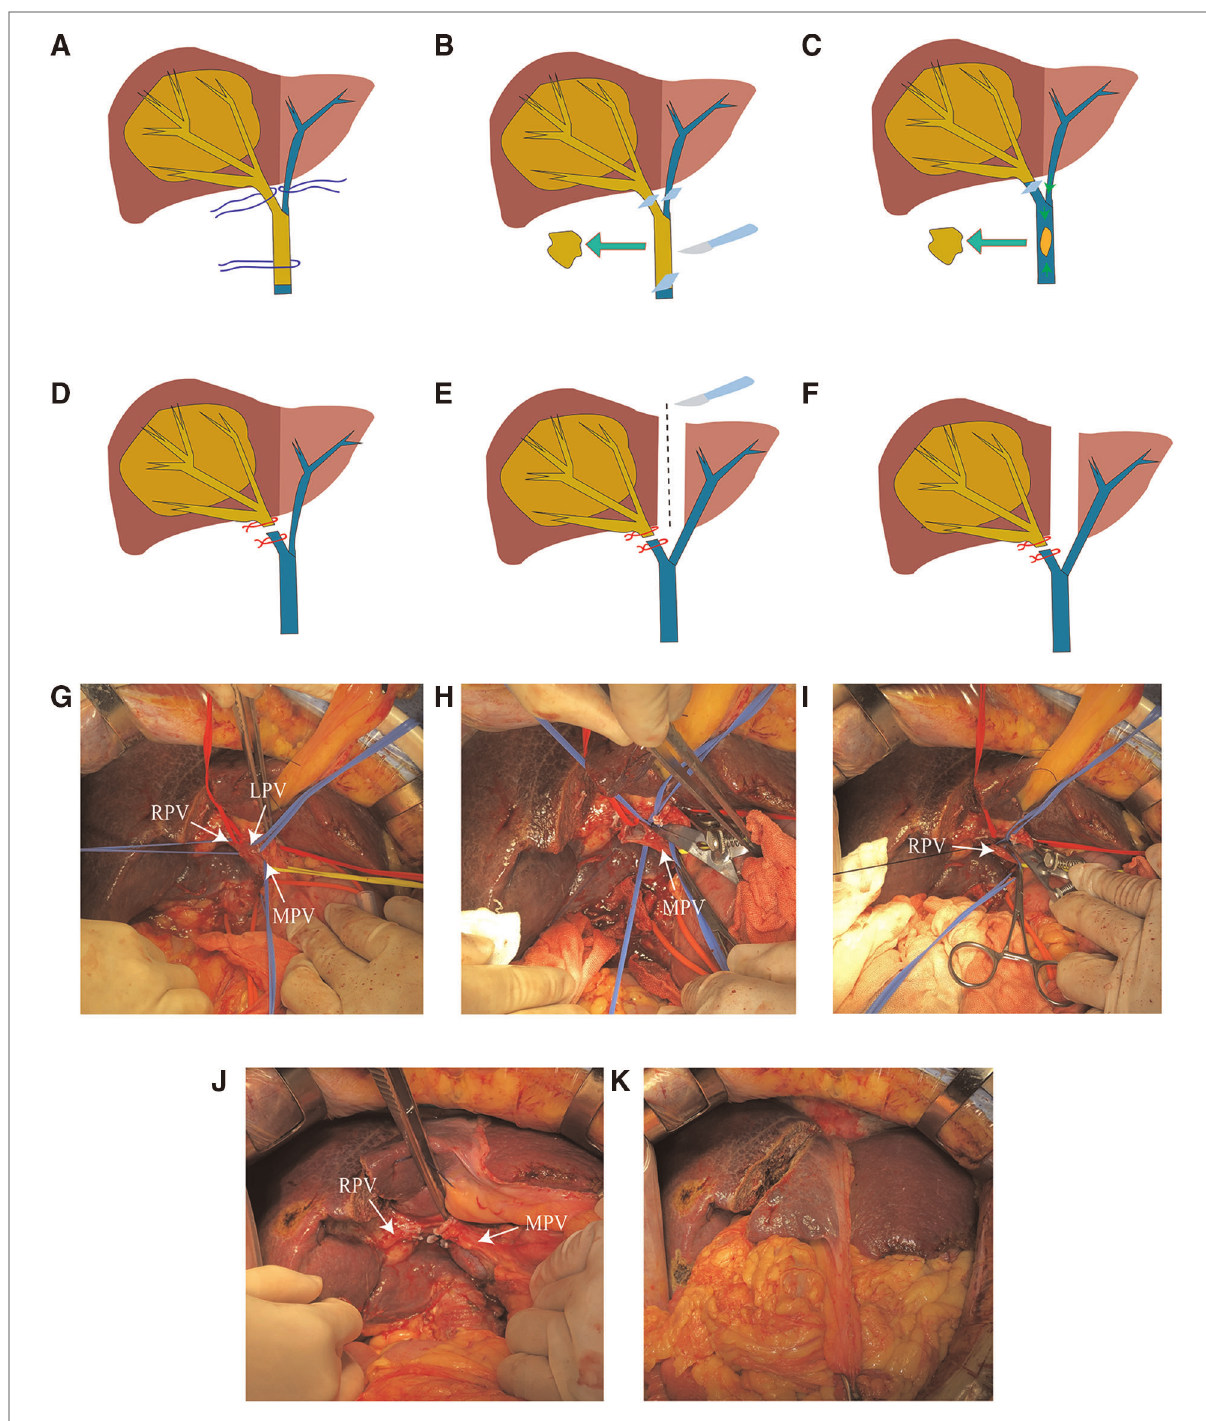
FIGURE 2 ( A ) Anatomical separation showing the LPV, RPV, and MPV. ( B ) Blocking the blood fl ow of the LPV, RPV, and PV and removing the tumor thrombus in the portal vein (PVTT). ( C ) Flushing out possible residual tumor thrombi by releasing MPV blood fl ow. ( D ) Ligation of the right portal vein stump. ( E ) Separation of the left and right liver parenchyma. ( F ) Completion of the CLAPT procedure. ( G ) Anatomical separation showing the LPV, RPV, and MPV. ( H ) Cutting the portal vein to remove the tumor thrombus. ( I ) Ligation of the RPV stump. ( J ) Separation of the left and right liver parenchyma. ( K ) Photograph of the operation